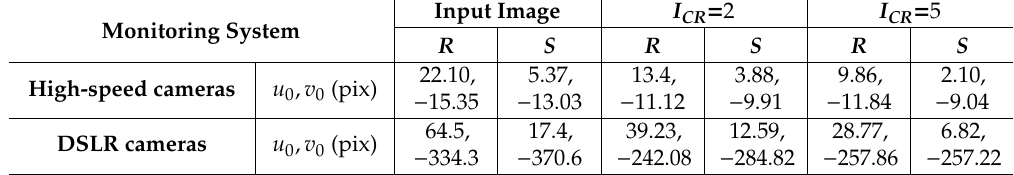
Table 9. Selected results of photogrammetry (principal point coordinates) for the two-vision sensor systems using original images and compressed images with applied bicubic interpolation